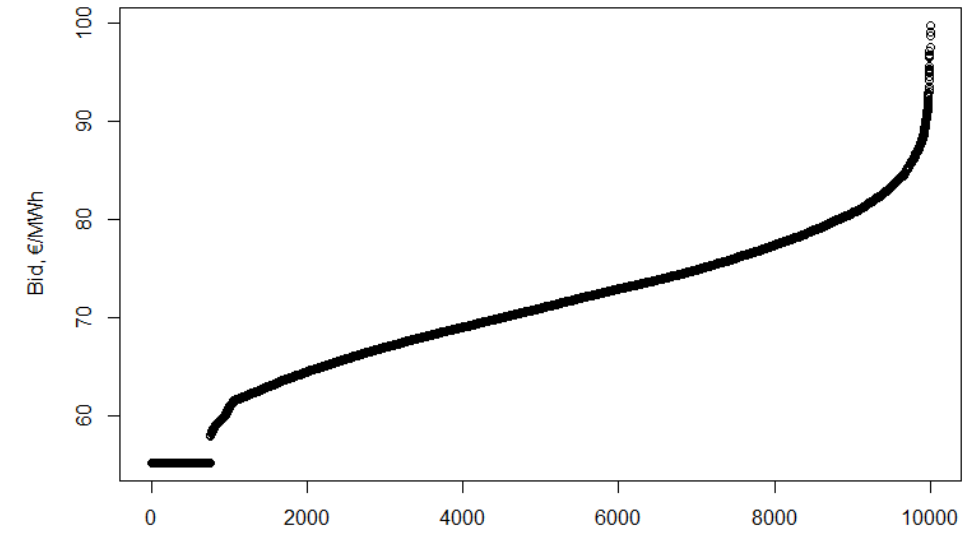
Figure A2. Sorted optimal bids, assuming F 1 bid distribution, source: own